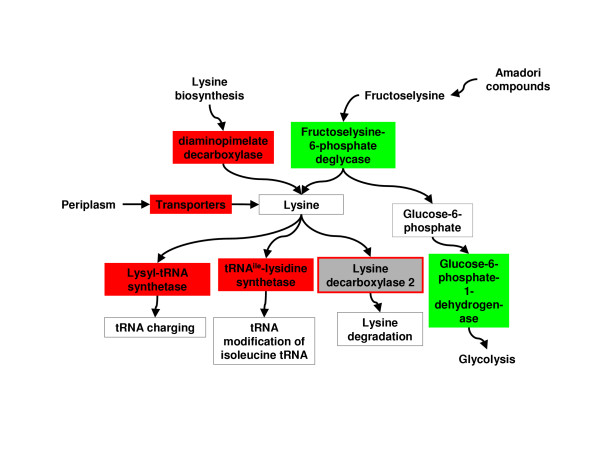
Seventh extracted sub-graph. Lysine biosynthesis, degradation (lysine decarboxylase, p-value: 0.16) and charging and modification of its corresponding tRNAs was down-regulated, while degradation of fructoselysine and its further processing into the glycolysis pathway was up-regulated. For box colours see legend of Figure 3.